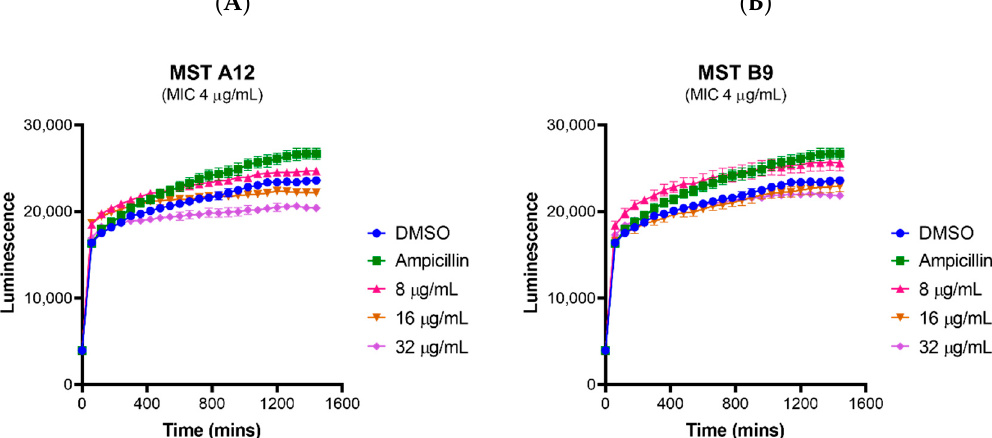
Figure 8. MST compounds are not cytotoxic to mammalian cells at concentrations of 2 × MIC. Two compounds A12 ( A ) and B9 ( B ) are presented as examples to illustrate these e ff ects. Real-time cell viability measurements for HepG2 after treatment with compounds at 2 × (pink line), 4 × (brown line) and 8 × (purple line) MIC. Controls of 1% ( v / v ) DMSO (vehicle control, blue line) and 50 µ g / mL ampicillin (green line) were used. Cell viability was measured every 5 min for 24 h at 37 ◦ C and 5% CO 2 on a Cytation5 ® Cell Imaging Multi-Mode Reader (Bio-Tek ® ) using the RealTime-Glo TM MT Cell Viability Assay reagent. The results are presented as the mean ± SEM (SEM is presented at every hour).